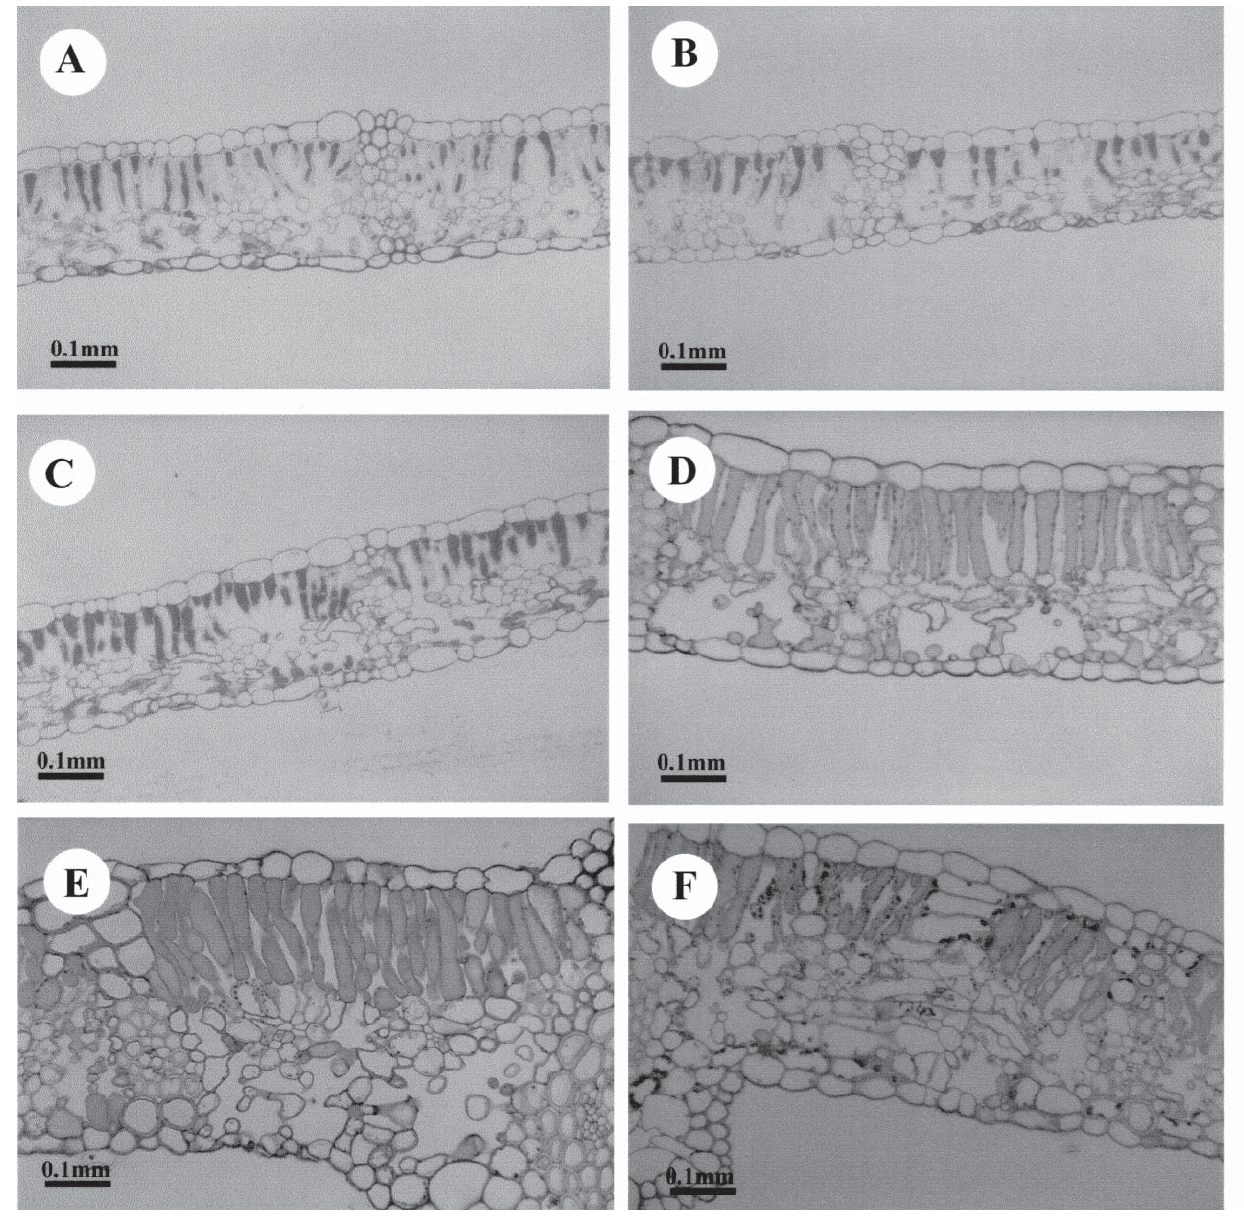
Fig. 2. Light microscopy sections of Platanus acerifolia leaves after the first (A, B, C, D) and second (E, F) exper- imental procedure. (A, B) Leaves treated with cerato-platanin (CP) and control leaves after 24 h: note the reduced leaf thickness due to plasmolysis and loosening of the spongy cells in the treated leaf as compared with the control. (C, D) Effects of Ceratocystis fimbriata f. sp. platani ( Cfp ) and CP after 48 h. More starch grains are formed with CP than with Cfp . (E, F) Control and CP treated leaves after 48 h. The higher starch levels in all leaf cells with CP applied to the leaf surface are clearly visible: in the control leaf starch remains very low. All pictures bar=0.1